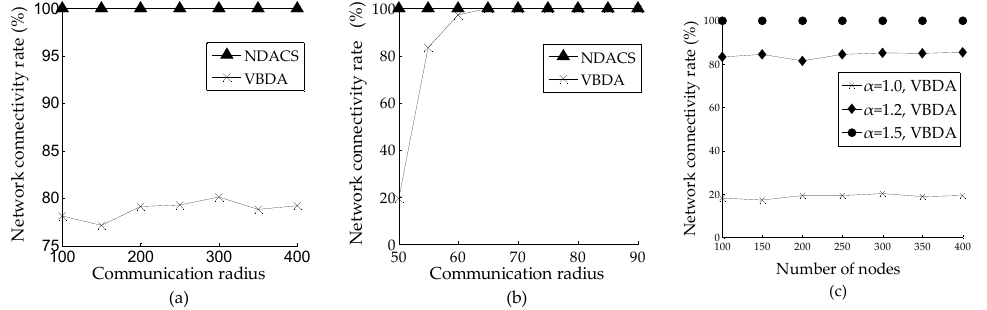
Figure 10. Comparison of network connectivity rate between NDACS and VBDA: ( a ) comparison of network connectivity rate between NDACS and VBDA varying with number of nodes, and the initial communication radius is 60 m; ( b ) comparison of network connectivity rate between NDACS and VBDA varying with communication radius, and the default number of nodes is 200; ( c ) network connectivity rate of VBDA varying with number of nodes on different values of α .